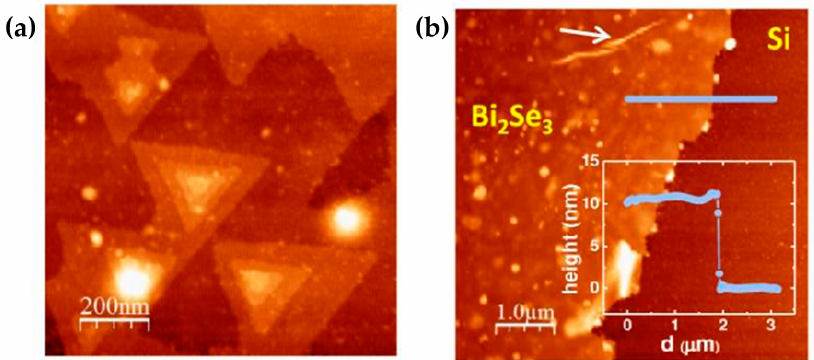
Figure 3. Characterization of the transferred film: ( a ) AFM image of the 10 QL film transferred to Si (111), exhibiting the pristine morphology of the transferred film; ( b ) A large area AFM image (5 × 5 μ m 2 ) showing the edge of the transferred film; the inset shows the height profile of the film along the line drawn on the image [67].